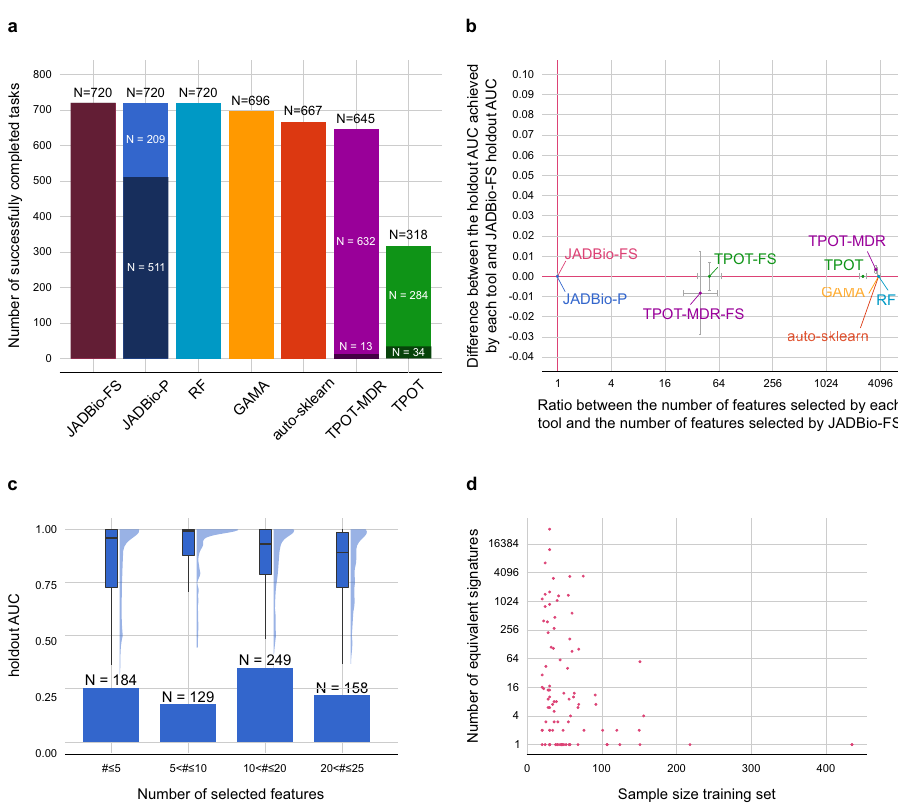
Fig. 4 Results of the quantitative comparison in terms of predictive performance. a Number of successfully completed tasks out of 720 for each tool. AutoPrognosis never completes any run and is not shown. JADBio-P and TPOT-MDR do attempt feature selection. The portion of runs where feature selection led to a winning model is depicted with a darker shade in their respective columns. JADBio-FS always enforces feature selection. b Comparison between JADBio-FS and all other tools in terms of relative dimensionality reduction and performance gain. The dimensionality reduction with respect to JADBio-FS ( x -axis) is computed as the ratio between the number of features selected by each tool and the number of features selected by JADBio-FS (log2 scale). Values larger than one indicate that the tool selects more features than JADBio. The performance gain is reported on the y -axis, and it is computed as the difference between the holdout AUC achieved by each tool and the holdout AUC achieved by JADBio-FS. Values larger than zero indicate that the tool performs better than JADBio-FS. For each tool, we plot a point on the median values for each axis. Errors bars showing the standard error are shown. The median values are computed only on the completed runs. Cranberry-colored lines denote the baseline value, i.e., relative dimensionality reduction equal to one and performance gain equal to zero. c Holdout AUC distribution for JADBio-FS over different number of selected features. The holdout AUC distribution is reported both as a box and violin plot. d Contrasting the sample size in the training set ( x -axis) and the number of equivalent signatures identi fi ed by JADBio-FS ( y -axis, log2 transformed). Only runs where an algorithm able to identify multiple signatures was selected are shown. More than one signature was identi fi ed in a total of 68 runs out of 98, represented by the points with y coordinate larger than